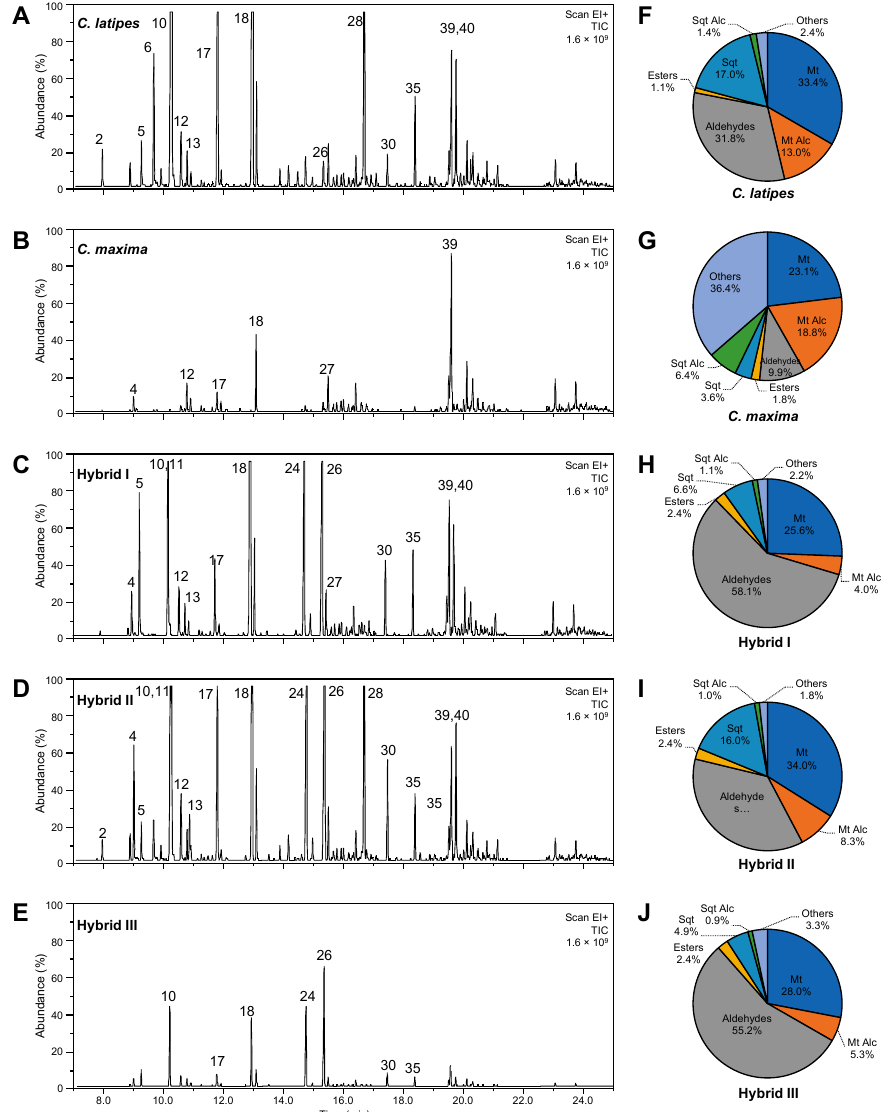
Figure 3. Volatile organic compounds (VOCs) detected in Citrus maxima , C.itrus latipes and their corresponding sexual hybrids (Hybrid I, Hybrid II and Hybrid III). ( A – E ) GC-MS representative chromatograms of the volatile organic compounds detected in the hexane extracts of leaves collected from C. latipes and C. maxima and their hybrids (Hybrid I, Hybrid II and Hybrid III), respectively. ( F – J ) Percentages of different volatile groups detected in the hexane extracts using GC-MS of leaves collected from C. latipes and C. maxima and their hybrids (Hybrid I, Hybrid II and Hybrid III), respectively. Abbreviations: Mt, Monoterpenes; Mt Alc, Monoterpene alcohols; Sqt, Sesquiterpenes and Sqt Alc, Sesquiterpene alcohols.